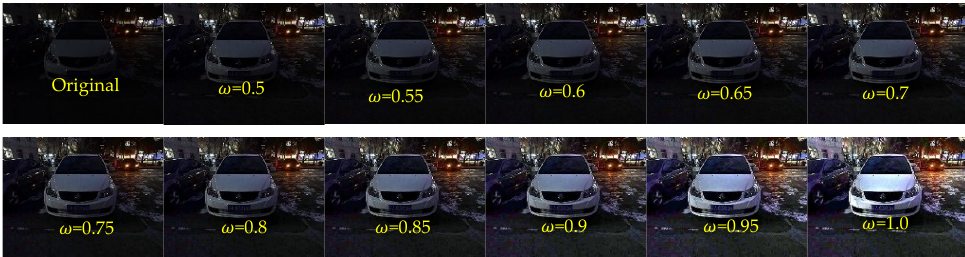
Figure 3. Influence of different values of the parameter 𝜔 on the enhancement results.